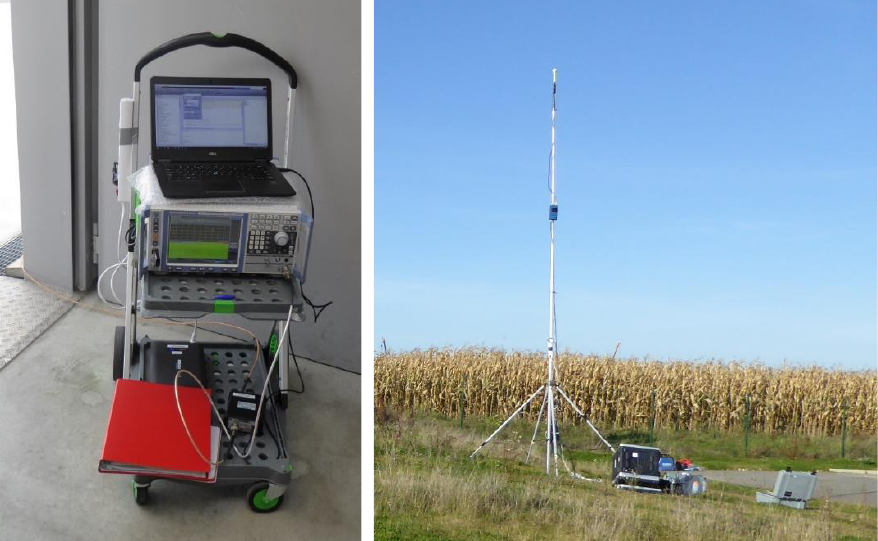
Figure 1. First type of equipment used in this study to measure the exposure to 5G new radio base stations, consisting of an R&S FSV30 spectrum analyzer controlled by a laptop (both on the ( left )), and an isotropic tri-axial R&S TS-EMF B2 antenna (on the ( right ), placed on a telescopic